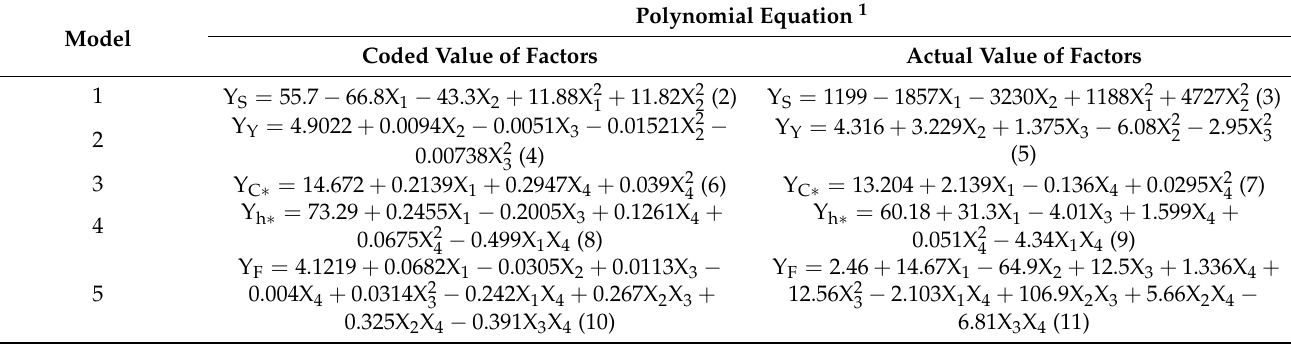
Table 4. Model equations for Y S , Y Y , Y C* , Y h* and Y F